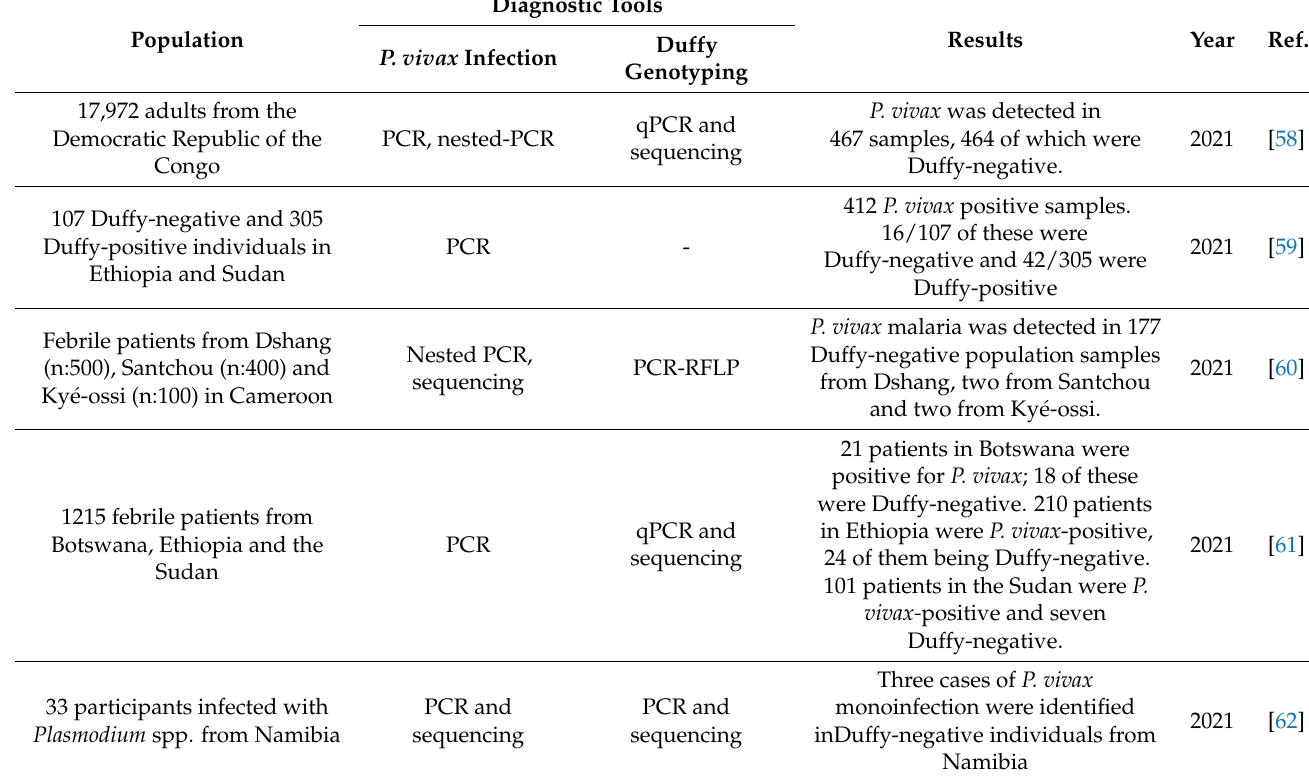
Table 1. X. P. vivax infection in Duffy-negative